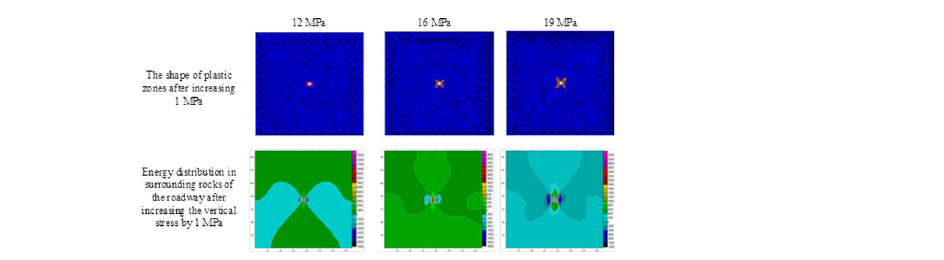
Fig 9. The shape of the plastic zone and the energy distribution of the surrounding rock of the roadway after the vertical stress increases by 1 MPa under different abutment pressures (12–19